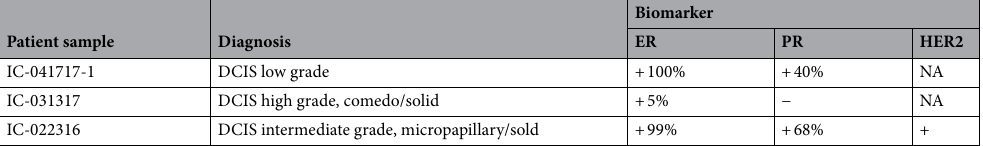
Table 2. Profile of de-identified patient samples used in mammary intraductal injection studies. Patient diagnosis, ER, PR, HER2 data were provided in pathology reports. IC-041717-1 and IC-031317 were obtained by needle core biopsy. IC-022316 were obtained through surgical biopsy. NA information not